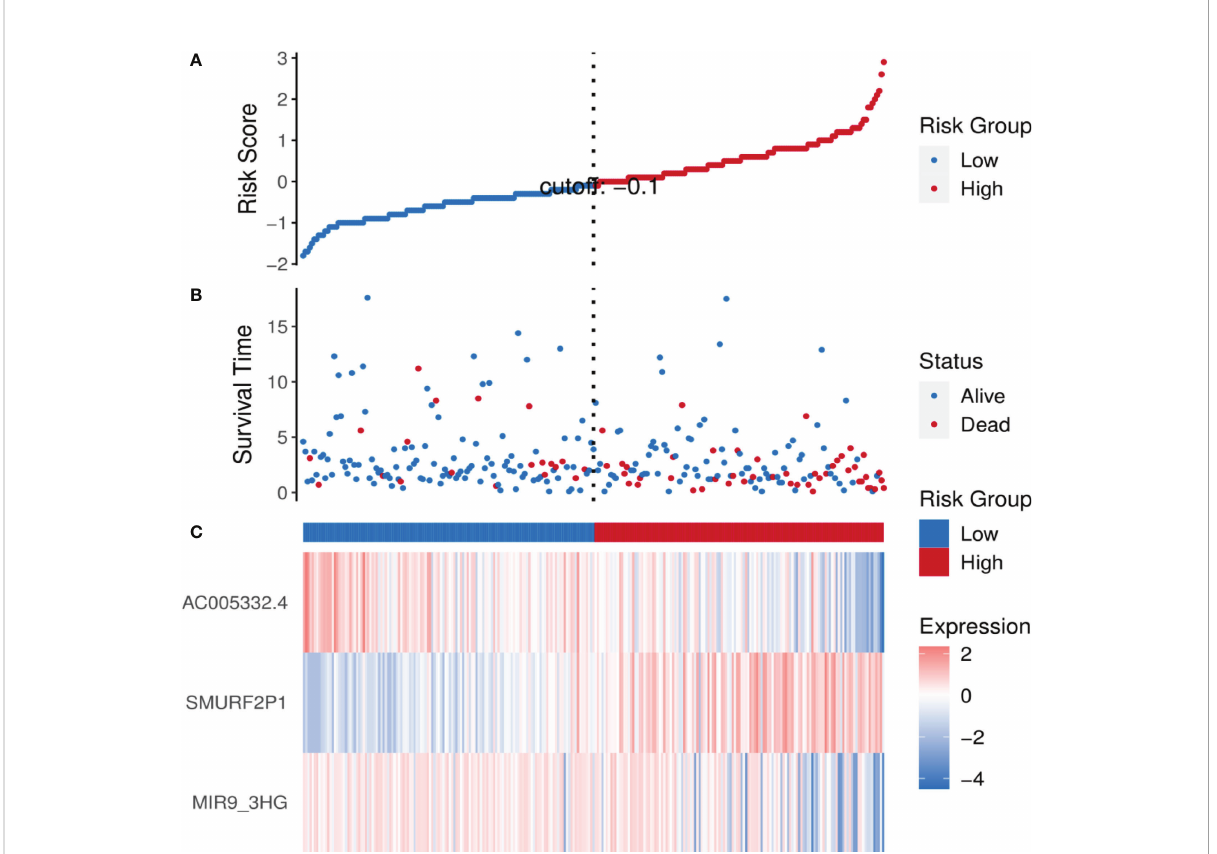
FIGURE 3 The analysis results of the ARL signature in CESC patients. (A) The risk scores of the two groups. (B) The CESC patients ’ survival time. (C) Heatmap of the expression of the three ARLs. The upward trend from low levels to high levels respectively corresponds to the colors from green to